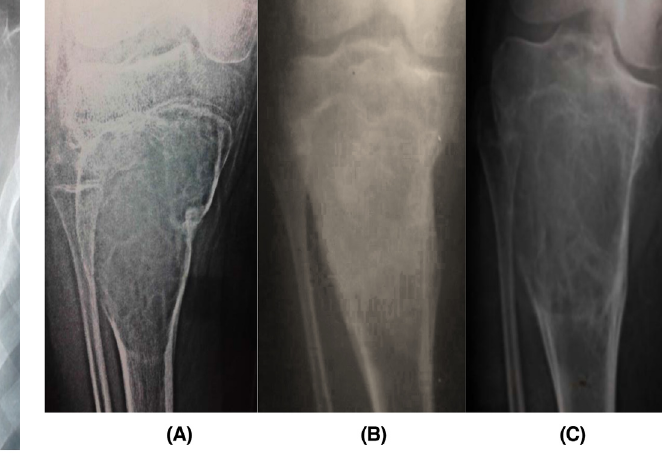
Figure 5. Serial radiographs of (A) 11 years old patient with ABC in the proximal tibia (case 16), (B) 3 months follow-up showed proper healing and cortical thickening, and (C) 5 months follow-up showed lysis in previously healed areas and bone expansion (signs of recurrence).